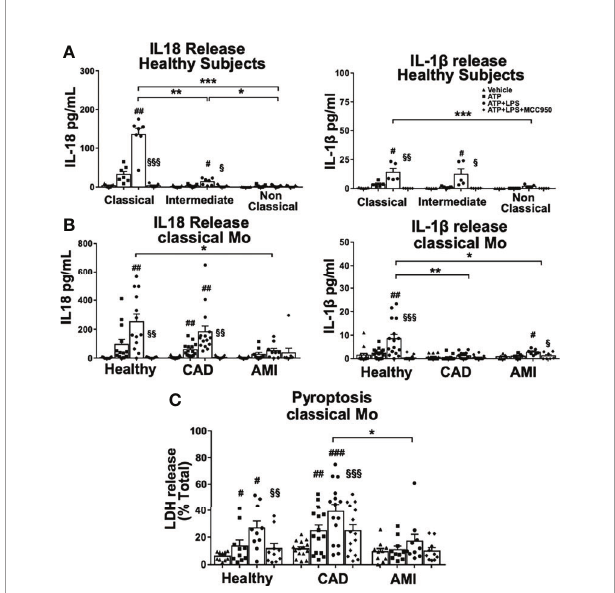
FIGURE 3 | IL18 release is predominant in classical monocytes upon rapid in fl ammasome activation and is greatly attenuated in AMI patients. ELISA measurement of in fl ammatory cytokines IL18 and IL-1 b released from monocyte subpopulations treated as described in Figure 1 . (A) Classical monocytes from healthy donors showed clear predominance for IL18 release compared to the two other subpopulations (n=5-7). IL18 release was completely inhibited by MCC950 treatment. IL-1 b was released at a much lower extent than IL18, but still signi fi cantly different between classical and non-classical monocytes. (B) Classical monocytes from AMI patients showed a signi fi cant impairment of both IL18 and IL-1 b release. Decreased IL18 release was not observed in monocytes from CAD patients. (C) LDH release as a measure of pyroptotic cell death was signi fi cantly induced upon rapid in fl ammasome activation in classical monocytes of healthy subjects and CAD patients but substantially attenuated in monocytes from AMI patients. # vs vehicle; § vs LPS+ATP; *, # or § p < 0.05; **, ## or §§ p ≤ 0.01; ***, ### or §§§ p ≤